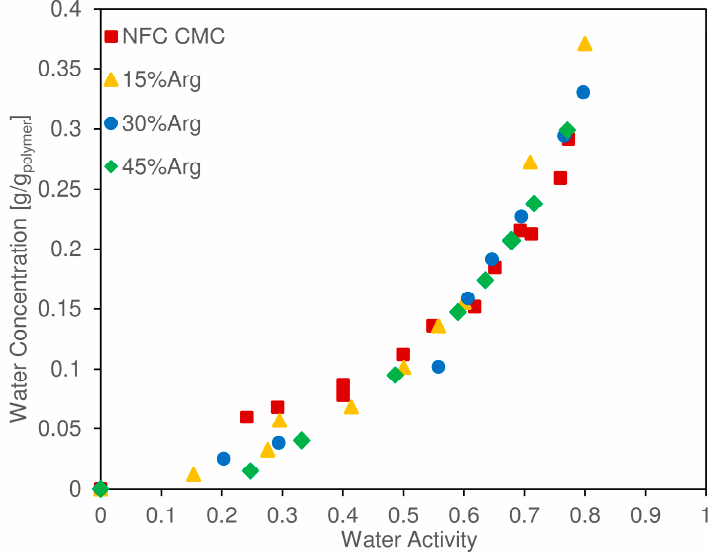
Figure 7. Water uptake of CMC-NFC films with different loadings of arginine at 35 °C.